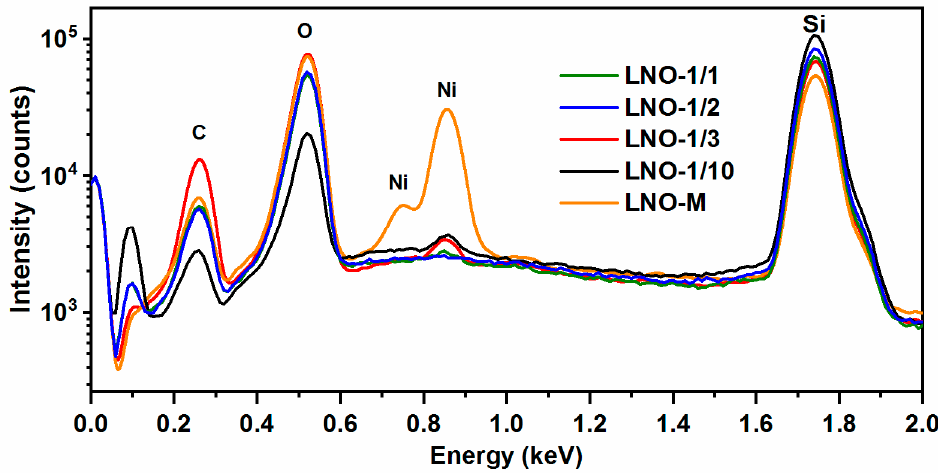
Figure 3. Energy-dispersive X-ray spectra (SEM-EDX) of the LNO samples.